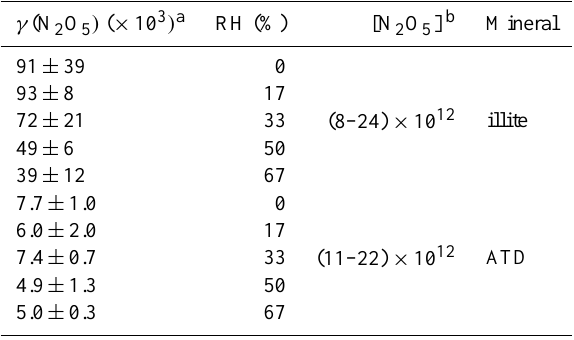
Table 1. Uptake coefficients for N 2 O 5 on illite and